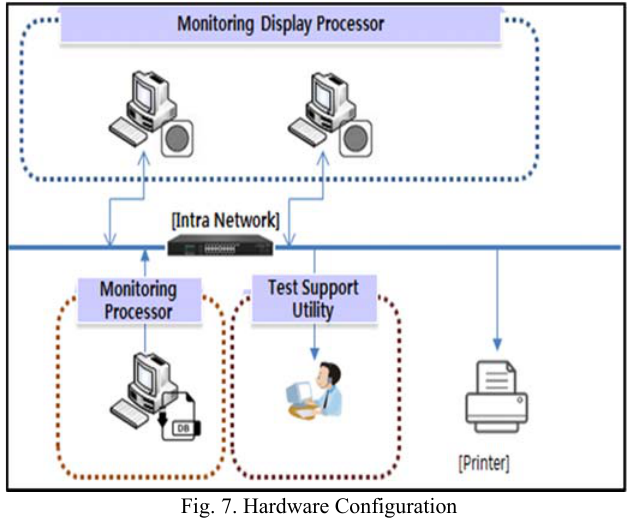
Fig. 7. Hardware Configuration